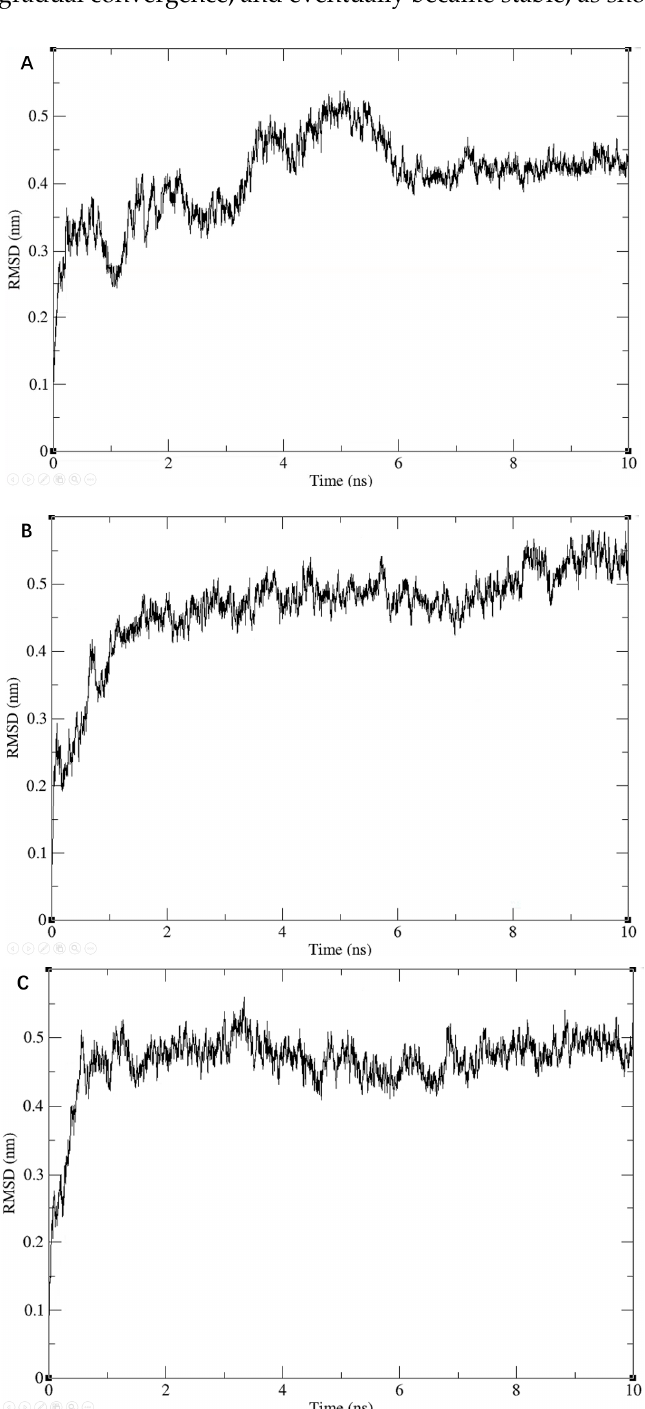
Figure 5. Results of the 10 ns molecular dynamic simulations for three ligand ‐ 2ZTT complexes. RMSD of Compound 3206 with protein ( A ); RMSD of Compound 4808 with protein ( B ); RMSD of Compound 15144 with protein ( C ).